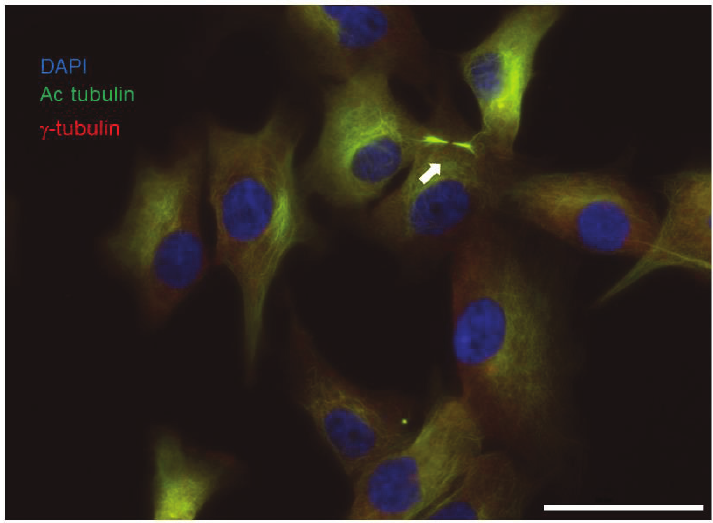
Figure 3. Primary culture of mesothelioma grown in the absence of serum and in 3% oxygen develop primary cilia. Primary mesothelioma cells were fixed in 4% paraformaldehyde, then were permeabilized in 0.1% saponin. Primary cilia (arrow) were detected using anti-acetylated tubulin (Sigma T 6793, 1:50), anti-gamma tubulin (Sigma T 5192, 1:1000) and Alexa 488 and Cy5-coupled secondary antibodies, respectively. Nuclei were stained with DAPI. Scale bar: 50 μ